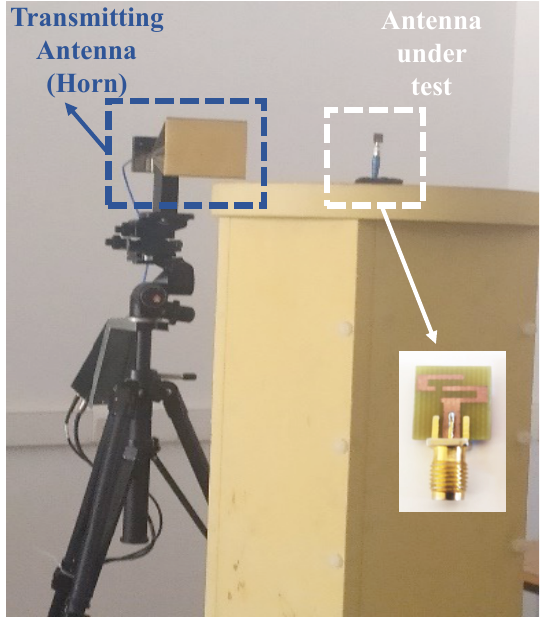
FIGURE 10. Measurement setup of the proposed